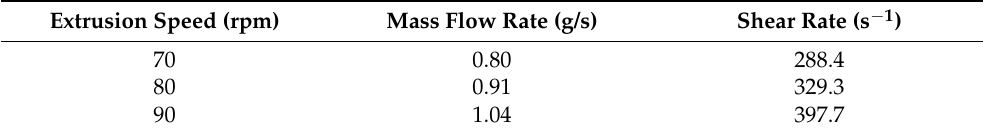
Table 9. Extrusion/deposition melt flow parameters for 200 ◦ C nozzle